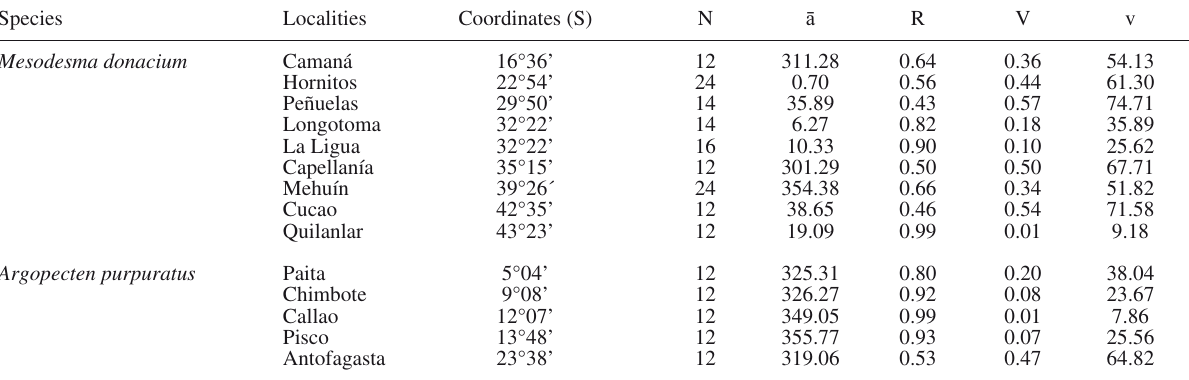
Table 1. – Circular summary statistical for each locality. Total sampling months (N), mean direction ( ā ), mean resultant length (R), circular variance (V) and standard deviation (v).